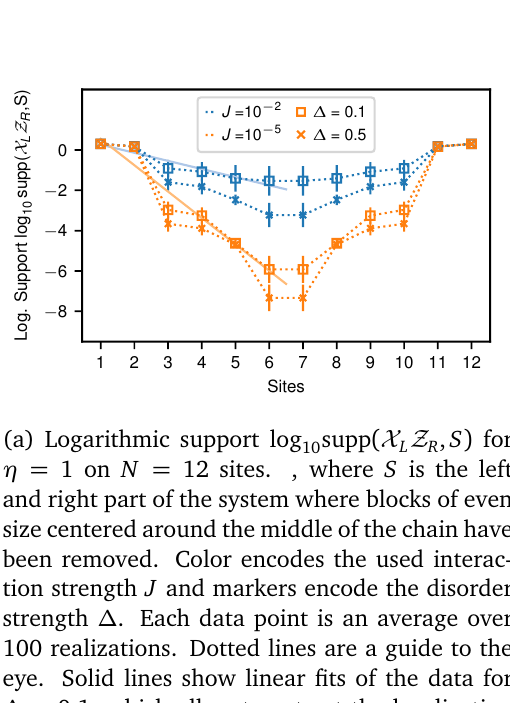
Figure 4: Additional numerical